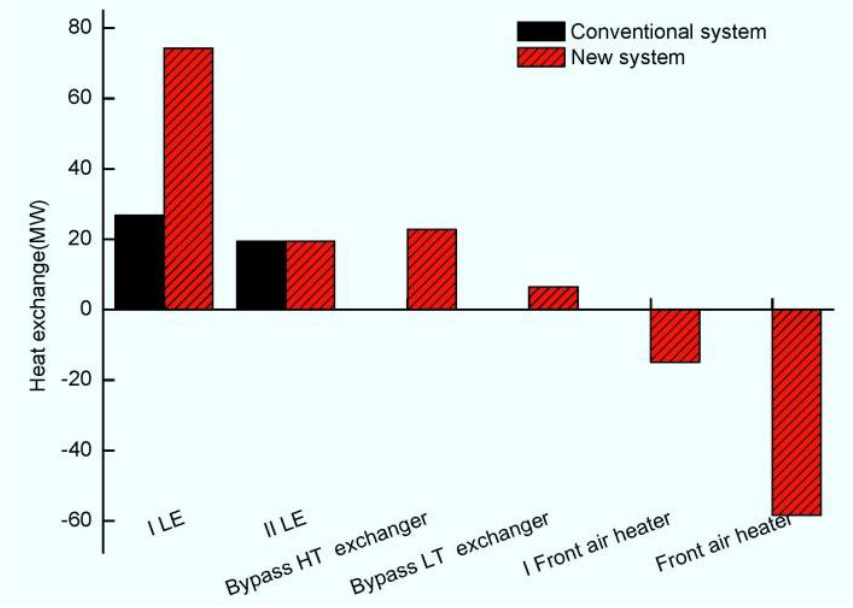
Figure 4. Waste heat system heat exchange.